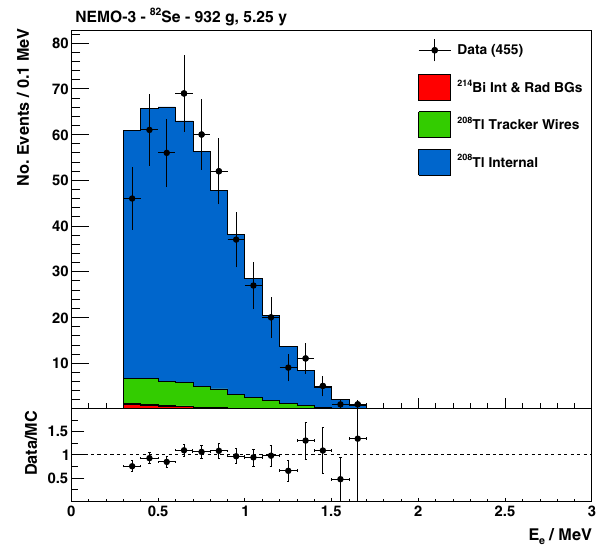
Fig. 5 Energy spectrum of electrons selected in the 1e2 γ channel, which contains an electron and two γ -rays. The channel is designed to allow a measurement of the source foil contamination with 208 Tl. Data are compared to the MC prediction, which is dominated by internal 208 Tl contamination with a small contribution from 208 Tl in the tracker wires